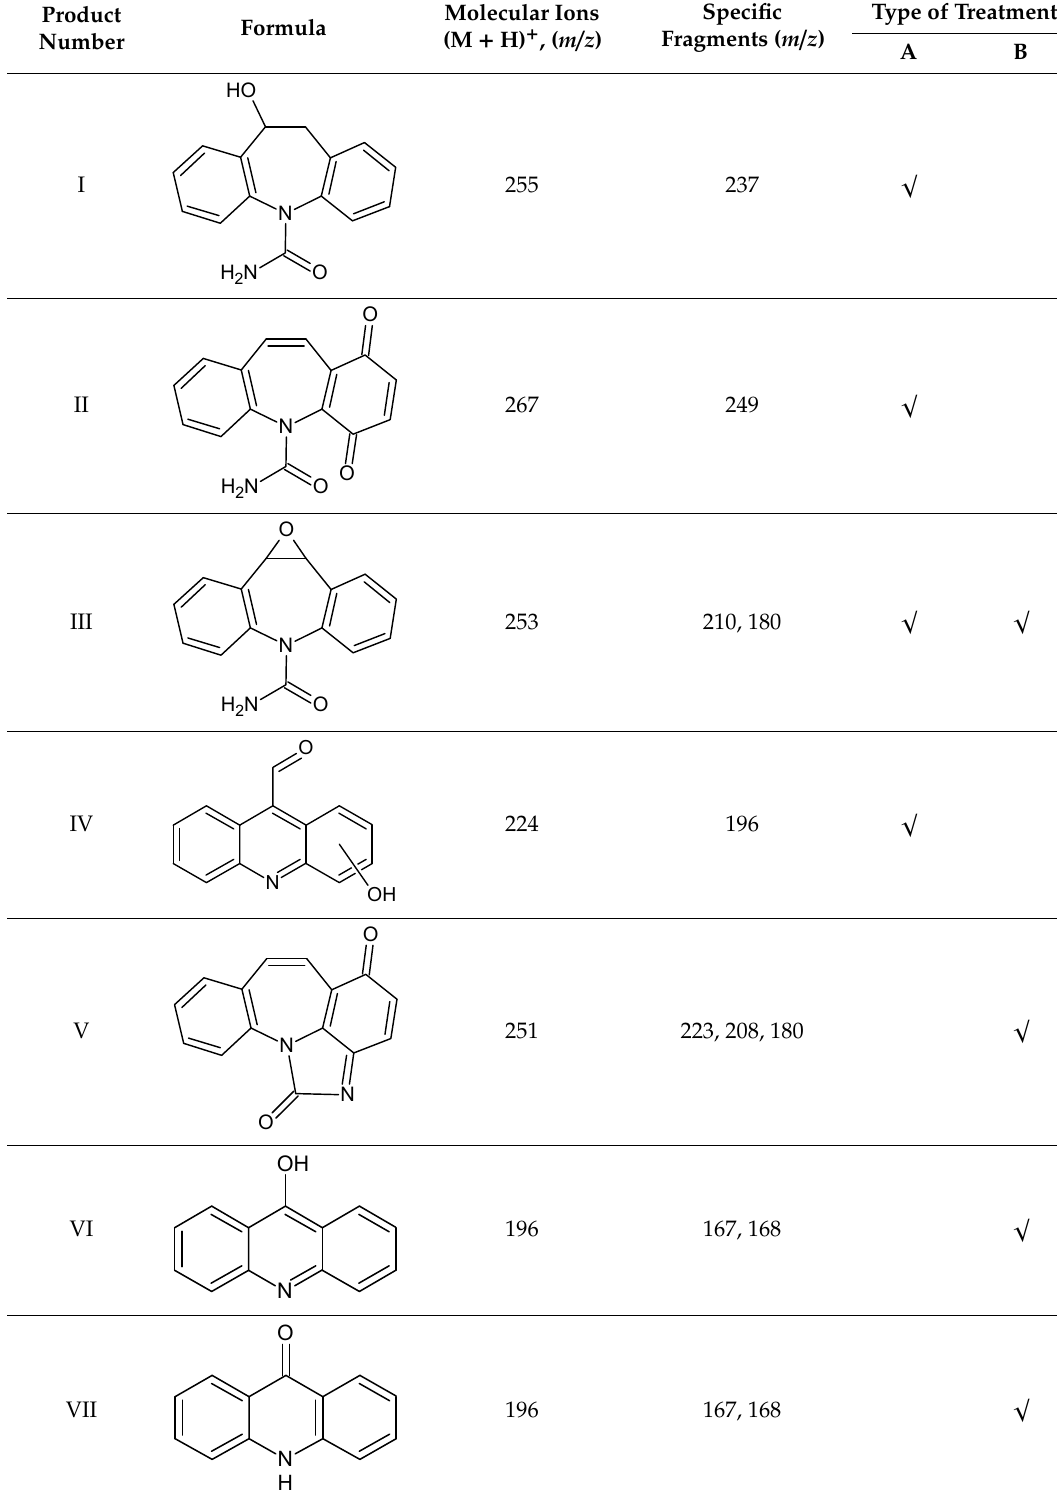
Table 1. CBZ photodegradation products detected by UPLC-MS-MS.